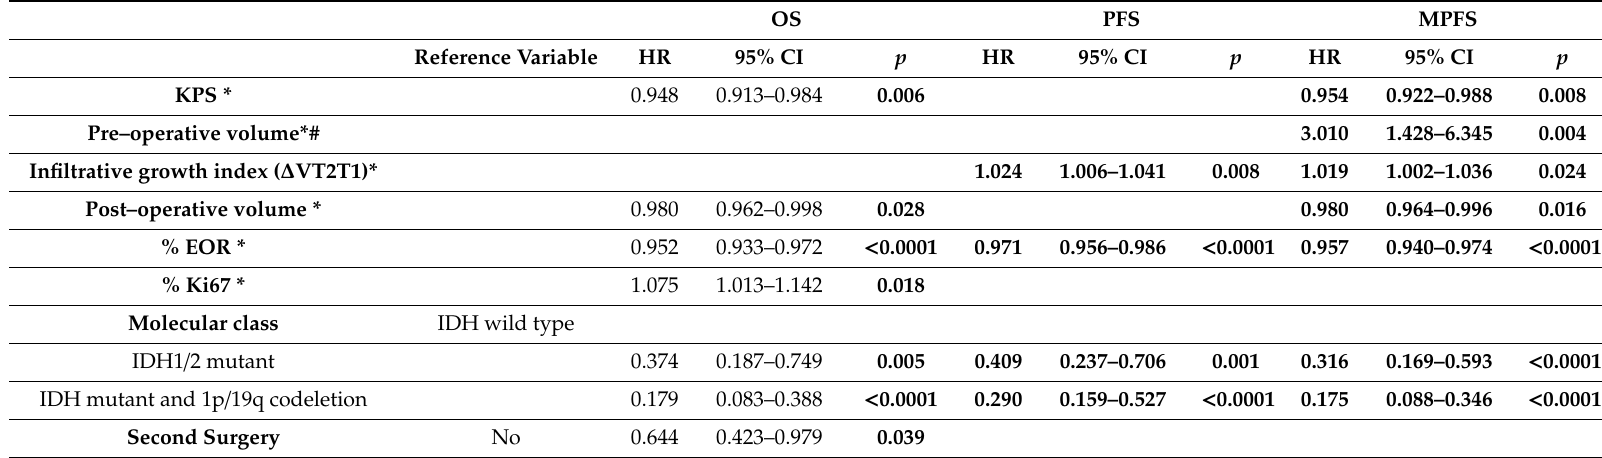
Table 4. Multivariate analysis of clinical, histological and molecular parameters in relation to overall survival (OS), progression-free survival (PFS), and malignant progression-free survival (MPFS) in 241 patients with